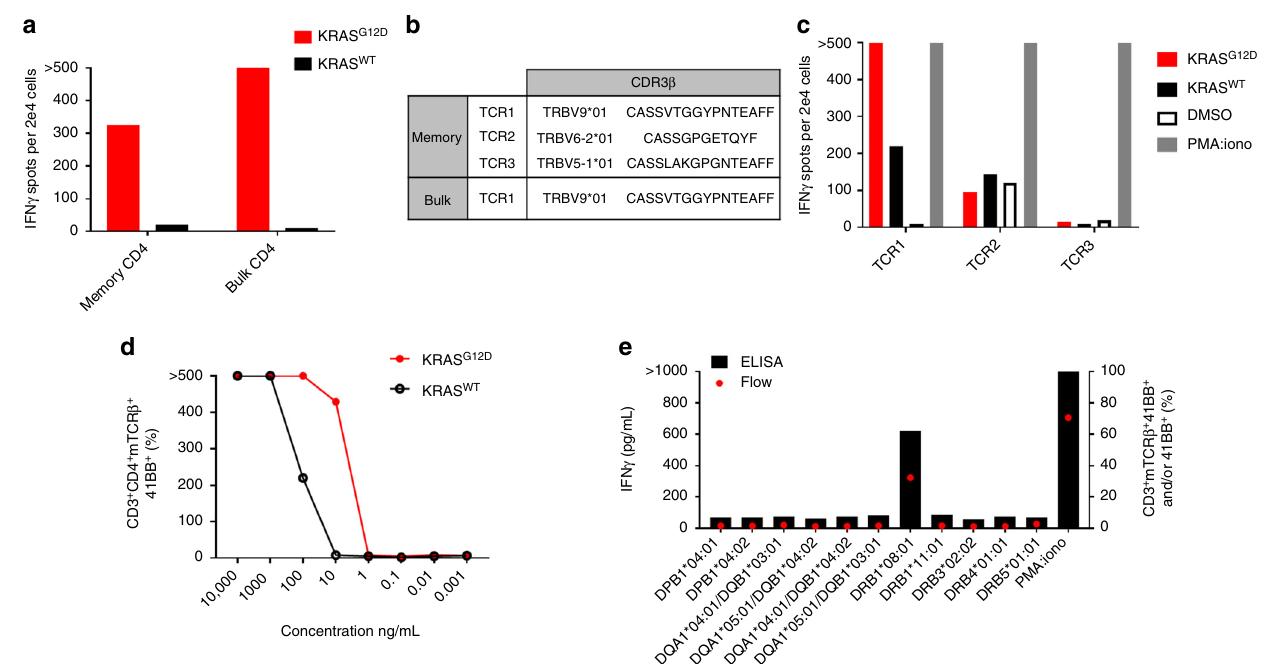
Fig. 4 Isolation of HLA-DRB1*08:01-restricted TCR-targeting KRAS G12D . a IFN γ -ELISPOT assay of 41BB + and/or OX40 + enriched CD4 subsets co-cultured with autologous DCs pulsed with mutated and wild-type KRAS peptides. b TRBV sequences of 41BB + -sorted T cells following co-culture with DCs pulsed with KRAS G12D peptide. c – e Retrovirally transduced allogeneic PBLs expressing the indicated TCRs were further tested. c Transduced PBLs were co- cultured with autologous DCs pulsed with either KRAS G12D or KRAS WT . d TCR1-transduced PBLs were co-cultured with DCs pulsed with a serial dilution of G12D or WT peptides. e COS7 cells were transfected with patient ’ s class II HLA and co-cultured with TCR1-transduced cells. Reactivity was determined